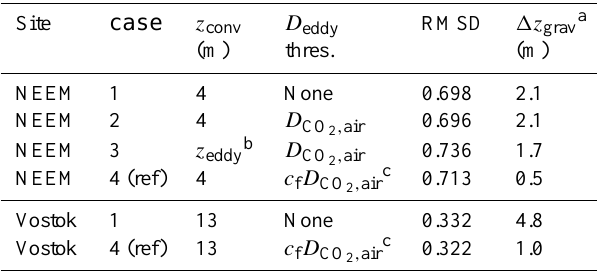
a 1z grav is the difference between the location of the modelled gravitational slope and the location of the gravitational slope observed on δ 15 N 2 (at 30m). b z eddy = 10 . 6 m. c with a correction factor c f = 0 . 65 to take into account the porosity effect (average surface